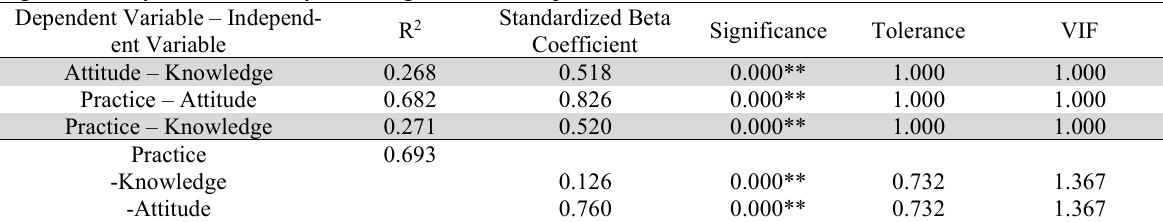
Regression analysis of food safety knowledge, attitude and